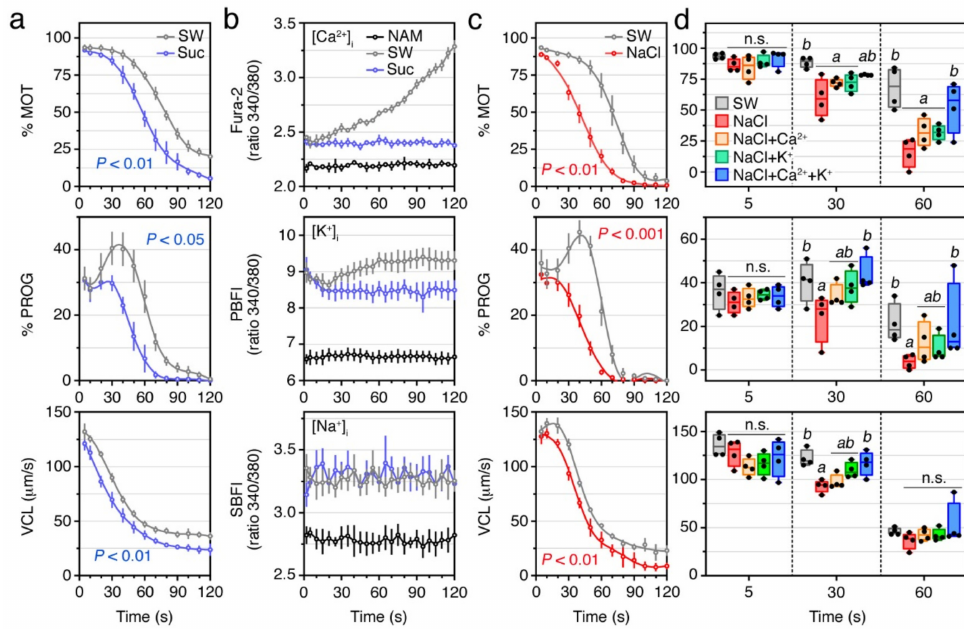
Figure 4. External ions are required for the maintenance of motility of post activated seabream spermatozoa. ( a ) Motility, progressivity, and VCL, of spermatozoa upon activation in SW or sucrose. ( b ) Intracellular Ca 2+ , K + and Na + levels in sperm activated in SW or sucrose. ( c ) Motility, progressiv- ity, and VCL, of spermatozoa upon activation in SW or 550 mM NaCl. ( d ) Effect of activation in SW, NaCl, or NaCl, in which 10 mM Ca 2+ and K + were added separately or together, on seabream sperm kinetics. In a-c, data are the mean ± SEM ( n = 4–5 males, one ejaculate per male), and were statistically analyzed by two-way ANOVA ( p values indicated in each panel). In ( d ), data points ( n = 4) are presented as box and whisker plots/scatter dots with horizontal line (inside box) indicating median and outliers. One ejaculate from each male was measured. Statistical differences were measured by one-way ANOVA for each post activation time point, followed by the Tukey’s multiple comparison test. Boxes with different superscript are statistically significant ( p < 0.05). n.s., not